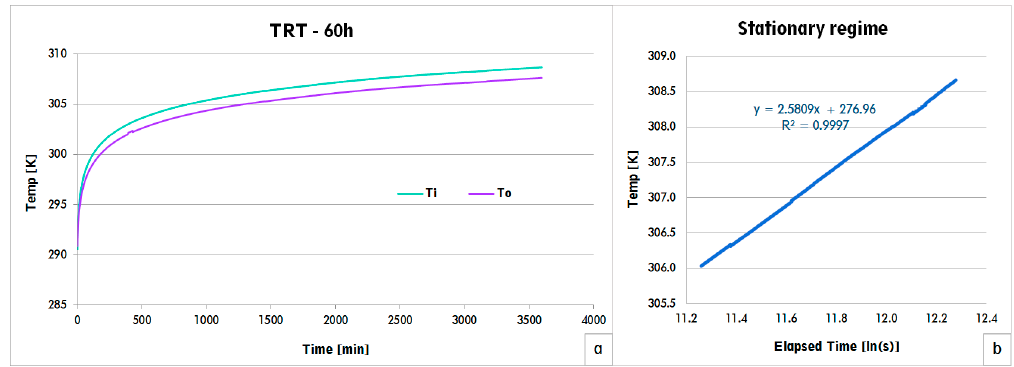
Figure 8. ( a ) TRT results for the time lapse of 60 h, ( b ) stationary regime considering 2300 sampling values.